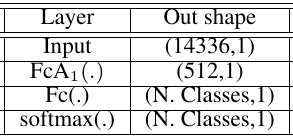
Table 1. Architecture of the SSRL-GAN Classifier.